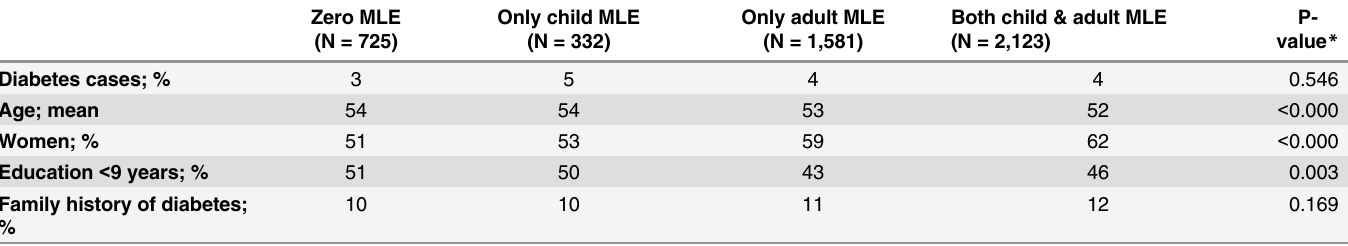
Table 1. Baseline Characteristics of 4,694 participants of the third and fourth waves of the Copenhagen City Heart Study by experience of major life